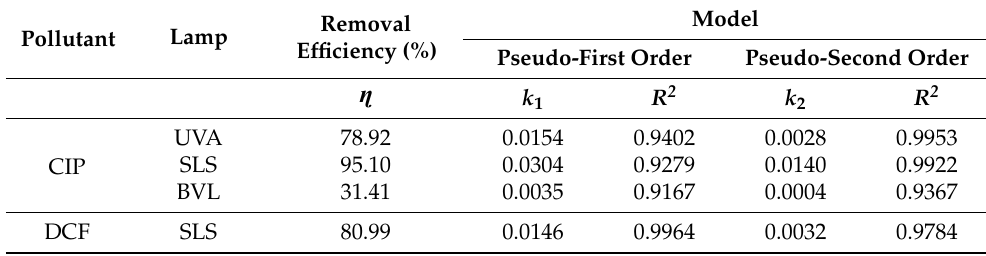
Table 4. Pseudo-first-order and pseudo-second-order kinetic parameters and efficiencies of CIP re- Table 6. Pseudo-first-order, pseudo-second-order kinetic parameters, and efficiencies CIP and DCF moval by N/TiO 2 , TiO 2 P25, and N/TiO 2 /rGO materials under UVA, solar light simulator (SLS), and removal by photolysis under UVA, solar light simulator (SLS), and blue visible light (BVL). cold visible light Model Removal Pollutant Lamp Efficiency (%) Pseudo-First Order Pseudo-Second Order